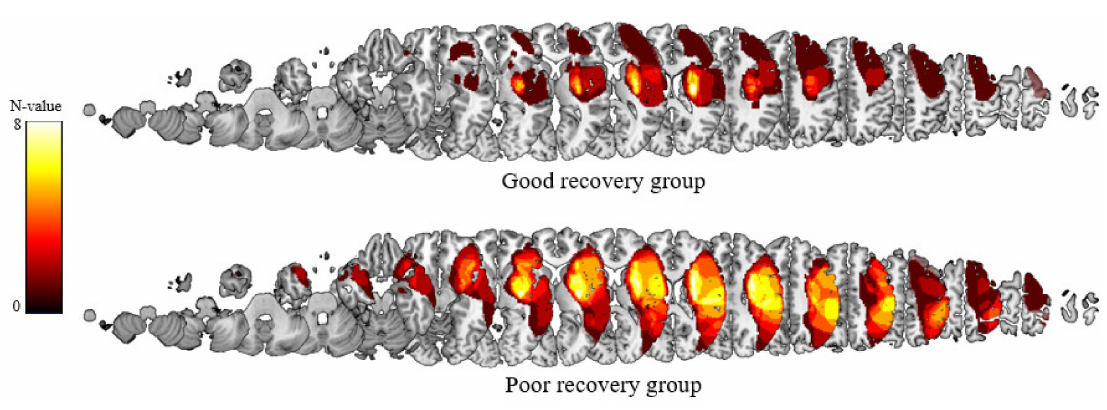
Figure 1. Total lesion overlay maps for the good recovery group and the poor recovery group.